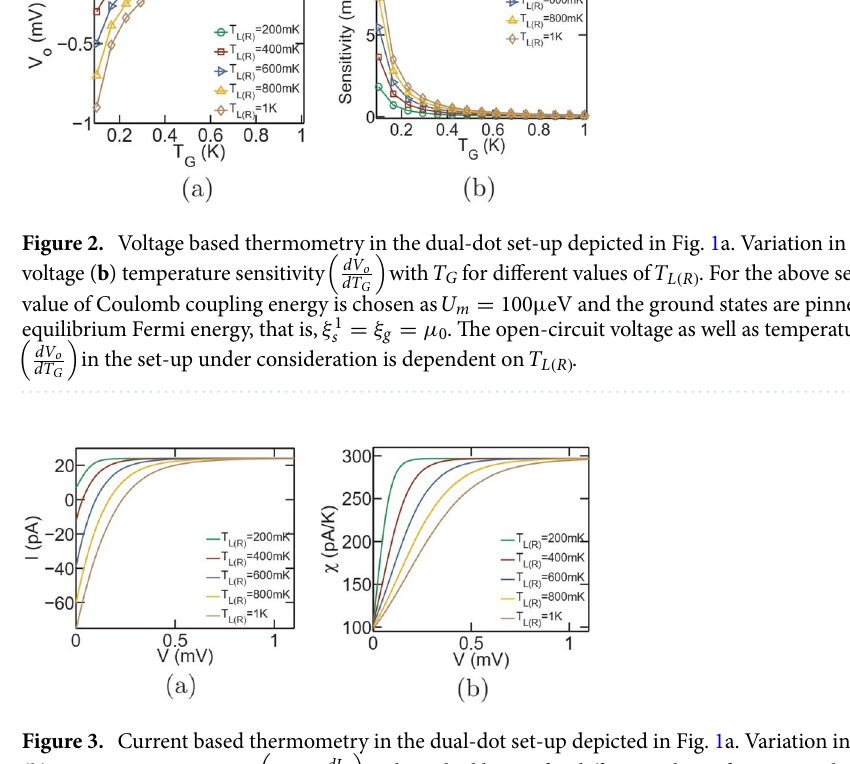
dI , dT G for different values of T L ( R ) at U m = 100 µ eV. It should G (cid:30) saturate to a finite limit for different values of T L ( R ) . Thus, G (cid:30)